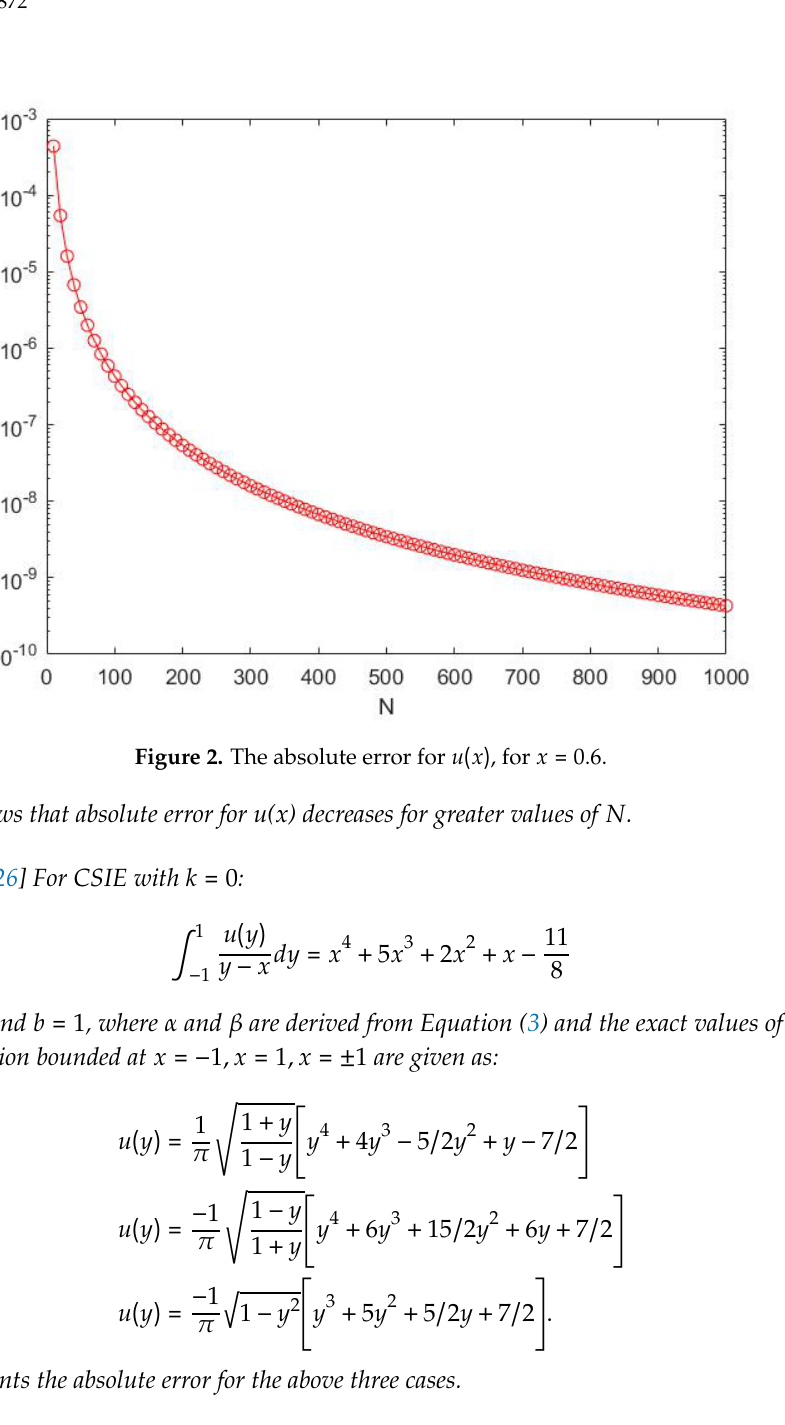
Table 3. Absolute error for case κ ≤ 0, k =